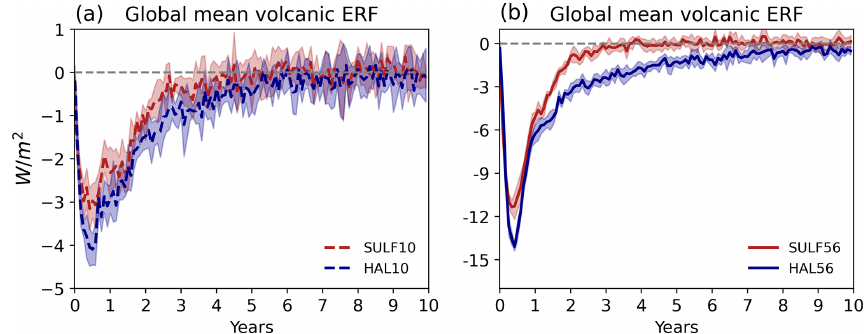
Figure 10. Evolution of the global-mean top-of-atmosphere total volcanic forcing (ERF) relative to the control climatology in SULF10 and HAL10 (a) and in SULF56 and HAL56 (b) . Volcanic ERF is the sum of ERF ari , ERF acii , and ERF clear , clean . Shading represents the ensemble